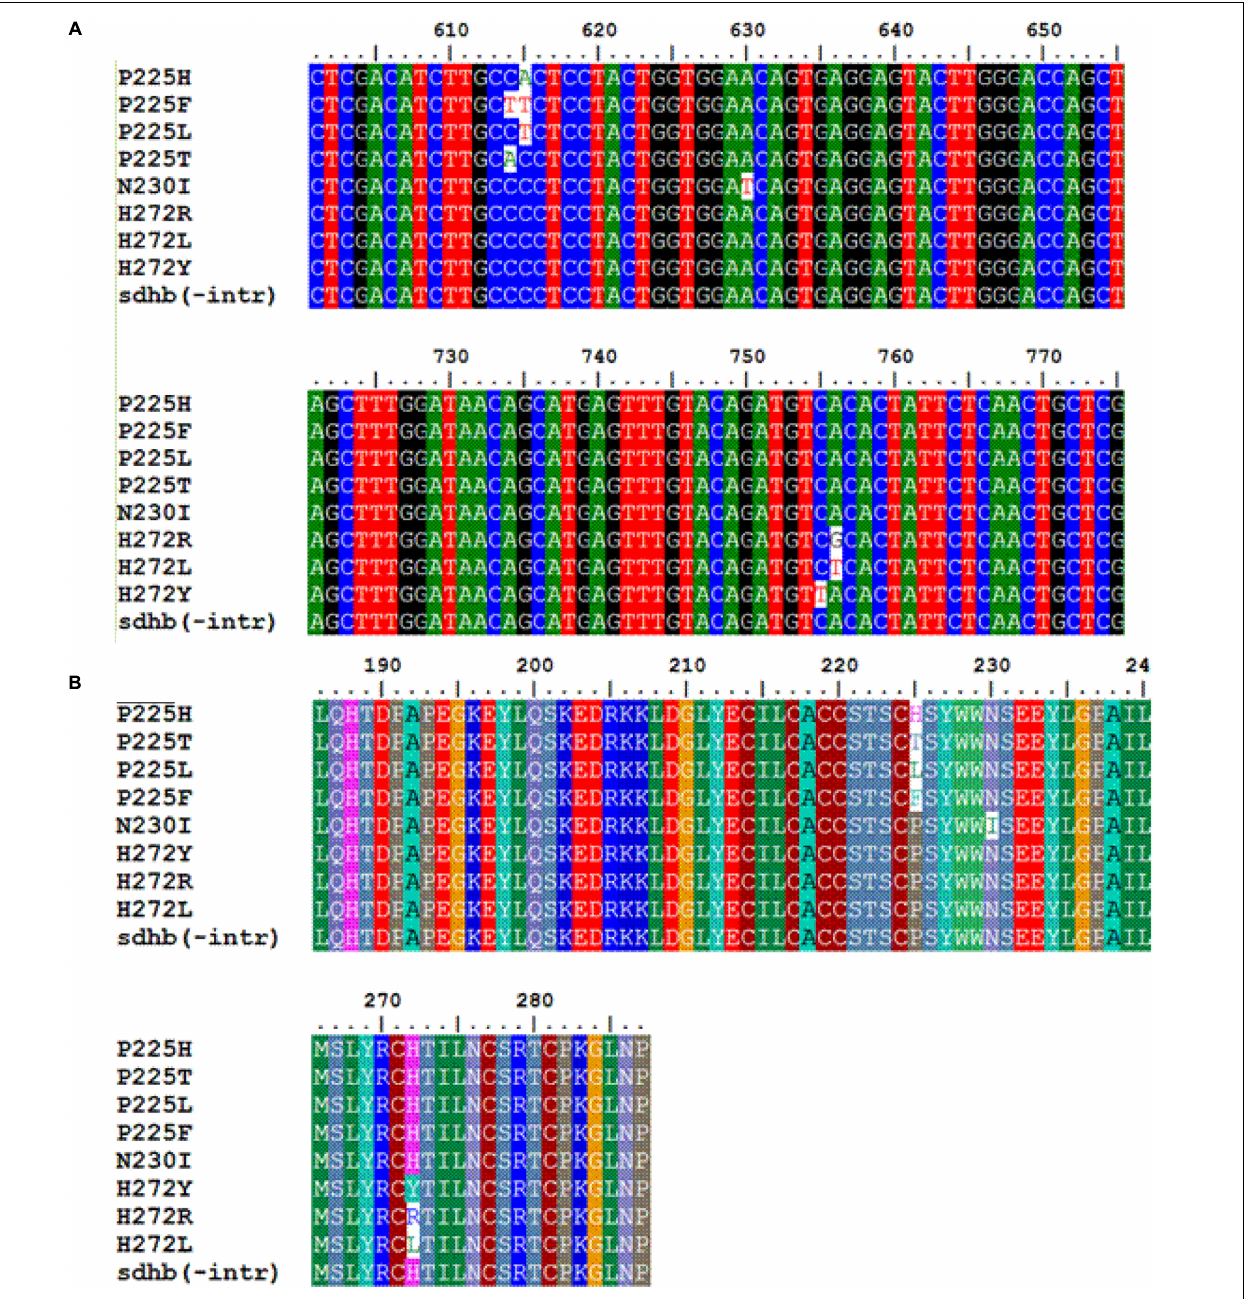
FIGURE 1 | Multiple sequence alignment of nucleotides (A) and amino acids (B) of the sdh B gene in SDHIs resistant isolates of Botrytis cinerea with eight different mutations in subunit B and one sensitive isolate.